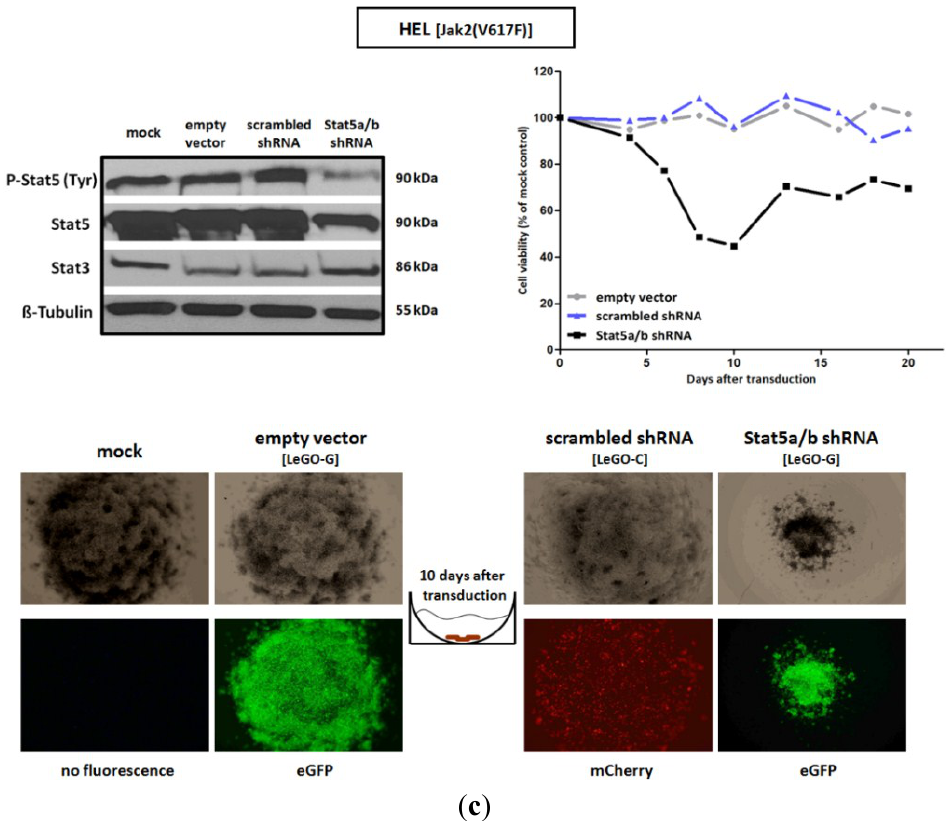
Figure 2. shRNA-mediated downregulation of Stat5 expression strongly reduces the survival of Bcr-Abl expressing K562 and Jak2(V617F) expressing HEL cells. ( a ) shRNA mediated downregulation of Stat5a and Stat5b expression. K562 and HEL cells were transduced with lentiviral vectors encoding shRNA directed against both Stat5 isoforms. Mock treated and empty vector (LeGO-G) transduced cells served as controls. Western blot analyses was used to visualize the expression of Stat5 and activated P-Stat5 6, 10 and 21 days after infection of the cells. Cell proliferation and viability were assayed over a period of 20 days after infection by XTT measurement ( n = 4; Ø ± SD). Significantly reduced XTT-values (percentage of mock control) were found when the cells were compared to empty vector expressing cells *** p < 0.001 (2-way-ANOVA with Bonferroni correction). Growth analyses were carried out by counting the cumulative cell numbers at each passage from day 3 to day 30 after infection ( n = 3; Ø ± SD); ( b ) Apoptosis measurement by Annexin V/7-AAD staining. Cells were stained and analyzed 10 days after transduction with shRNA-encoding lentiviral vectors. Divided FACS dot plots indicate unstained vital cells (lower left), early apoptotic cells positive for Annexin V (lower right), Annexin V/7-AAD double positive apoptotic cells (upper right) and late apoptotic/necrotic cells positive for -AAD (upper left); ( c ) In a control experiment K562 and HEL cells were treated with a lentiviral vector (LeGO-C) expressing a scrambled shRNA. Cell viability was measured over a period of 20 days by XTT conversion, whereas the corresponding suspension cell mass was documented after 10 days in assay-round bottom wells by phase contrast and fluorescence microscopy. After 14 days cell lysates were analyzed by western blotting with antibodies detecting Stat5 or P-Stat5, detection of Stat3 served as a control for the specificity of the of